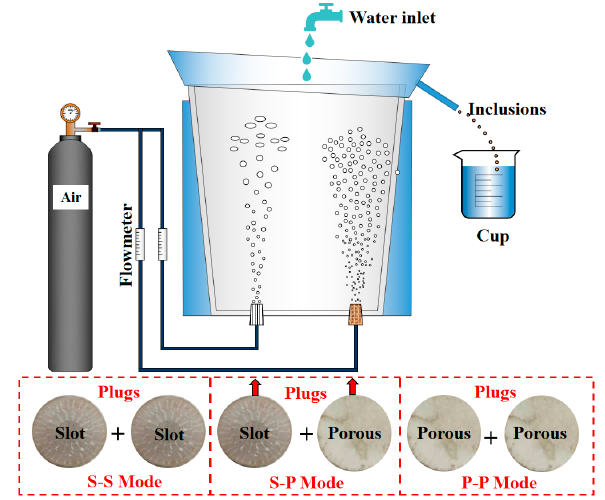
Figure 1. Geometry for water model experiment.